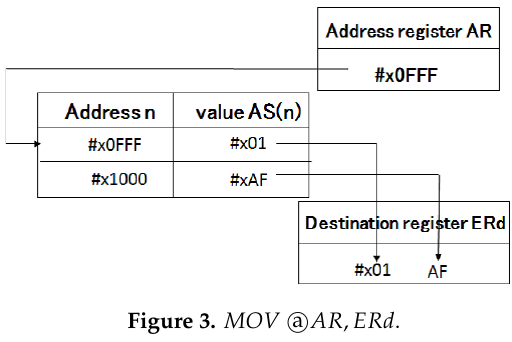
Figure 3. MOV a (cid:13) AR , ERd